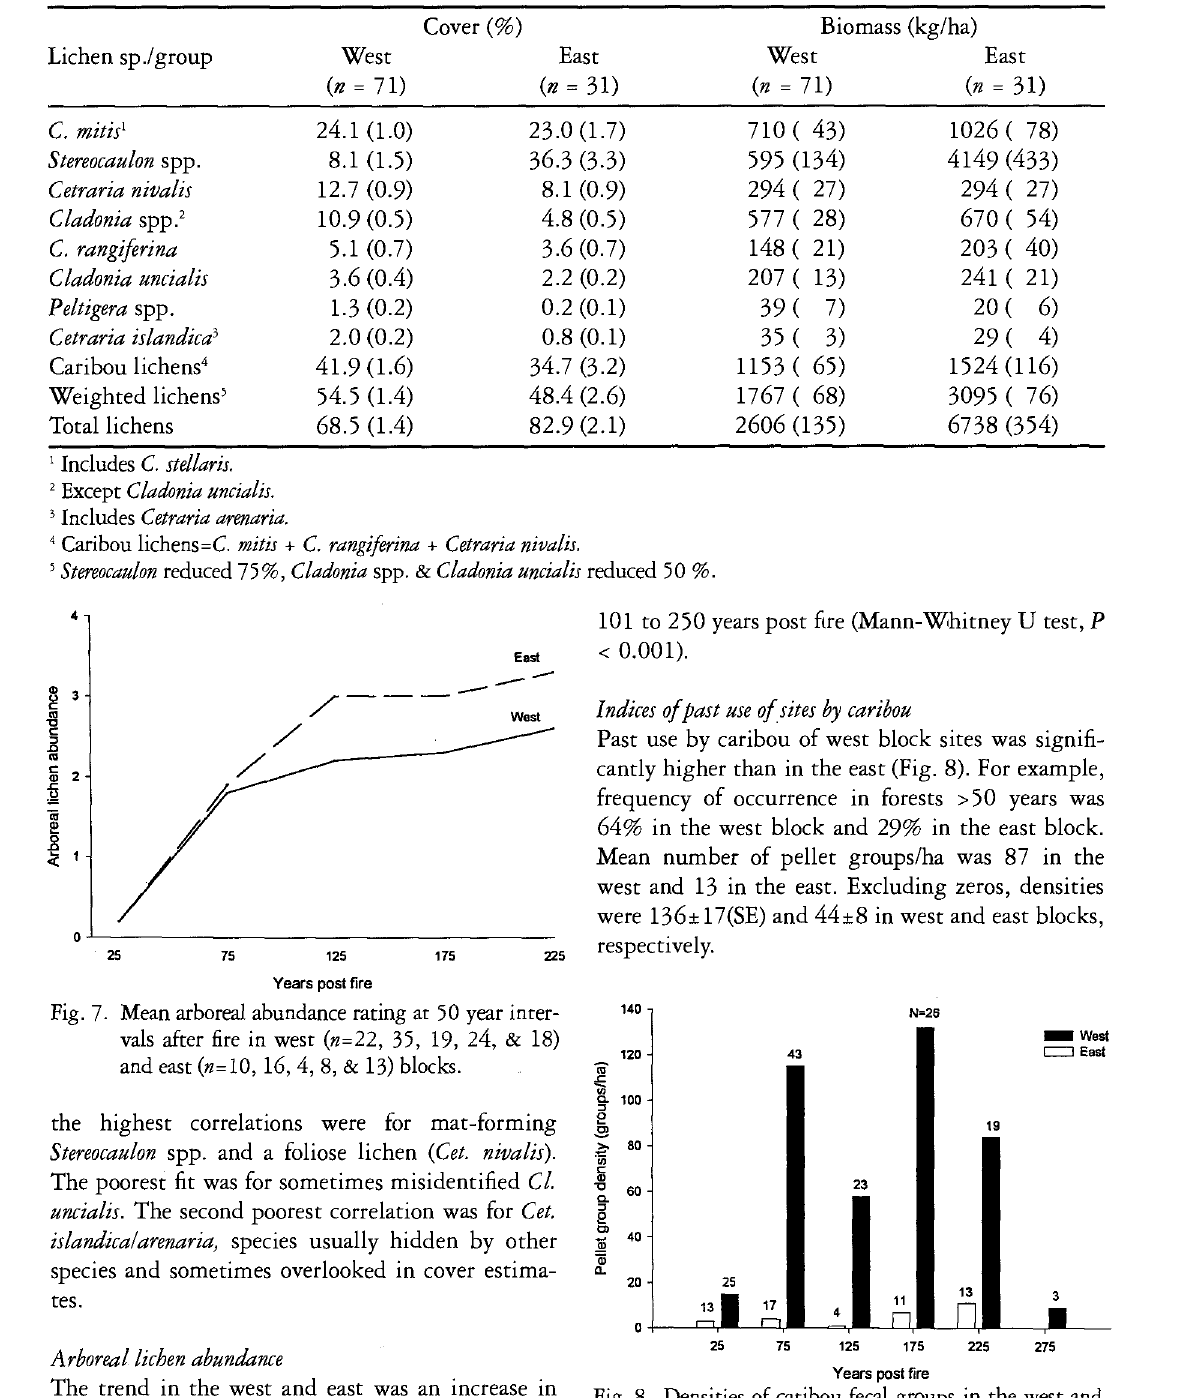
Years post fire Fig. 8. Densities of catibou fecal groups in the west